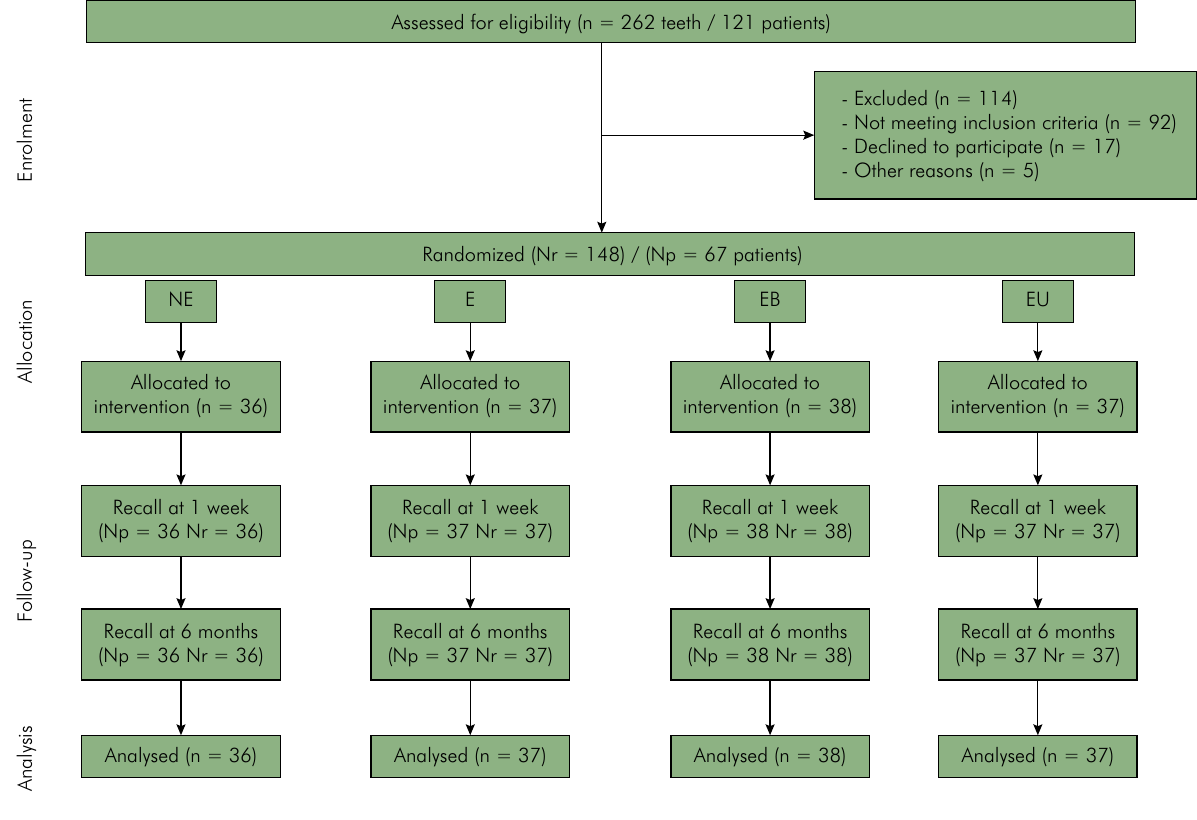
Figure 1. Flowchart including patient selection, restorations performed, and evaluation